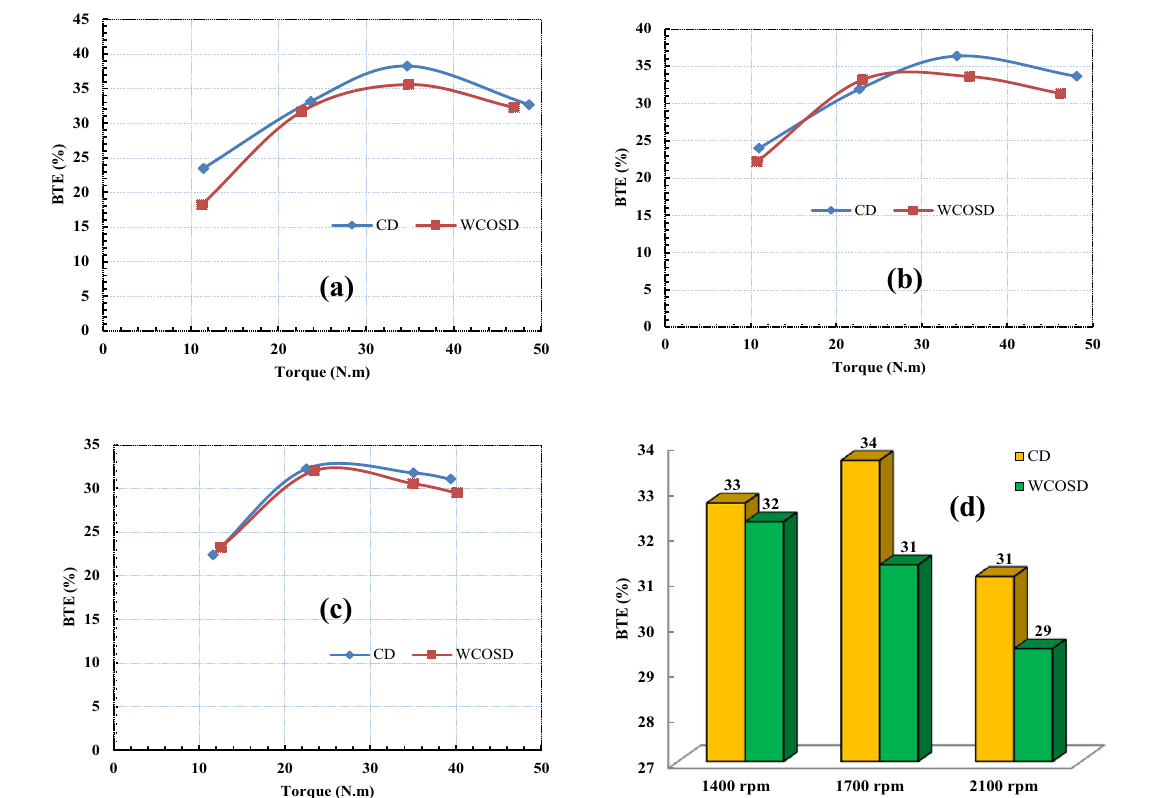
Fig. 5 Brake thermal efficiency of the test engine fueled CD and WOCSD at a 1400 rpm, b 1700 rpm, c 2100 rpm and d full